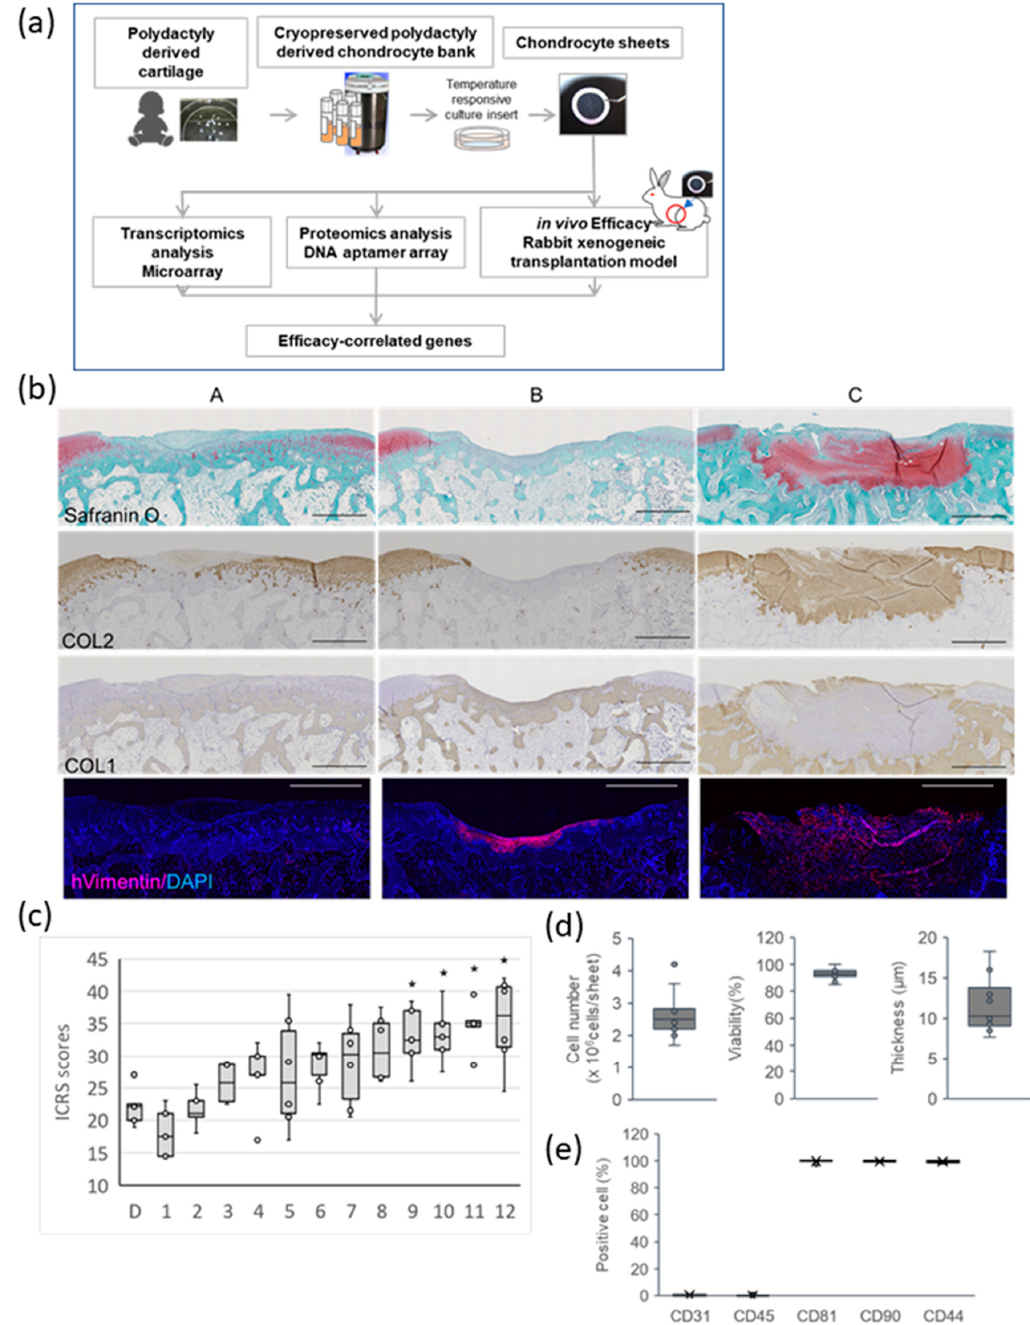
Figure 1. Comparison of 12 polydactyly-derived (PD) chondrocyte sheets with respect to their efficacy on hyaline cartilage regeneration in a rabbit xenogeneic transplantation model: ( a ) Overview of the study. ( b ) Representative images, using histological staining with safranin-O and immunohistochemical staining of COL2, COL1, and vimentin for rabbit knee cartilage defects with and without treatment with cell sheet transplantation. A: no sheet transplantation, B: poor cartilage repair (#1 in ( c )), C: excellent cartilage repair (#12 in ( c )). Scale bar = 1 mm. ( c ) ICRS scores for the PD sheets: Each circle indicates the average ICRS score for rabbits in a group. D represents a group without PD sheet transplantation. The number indicates each lot of PD sheets in Supplementary Table S1. * p < 0.05. ( d ) Distribution of PD sheet characteristics: Cell sheets were dispersed by enzymatic digestion, with cell numbers and the viability of cell suspension being determined. ( e ) PD sheets showing similar surface marker expressions.